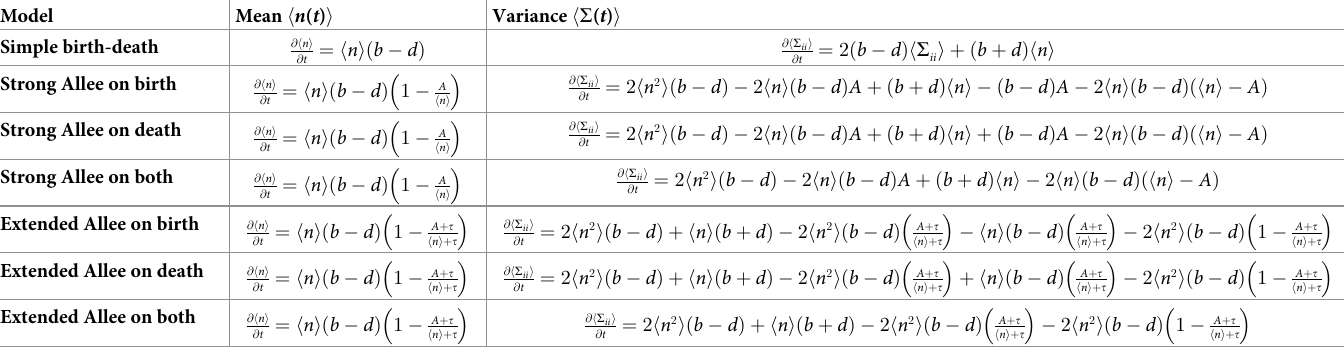
Table 2. Differential equations of the moment-closure approximations of the mean and variance for each stochastic model obtained from the ME using the moment approach.